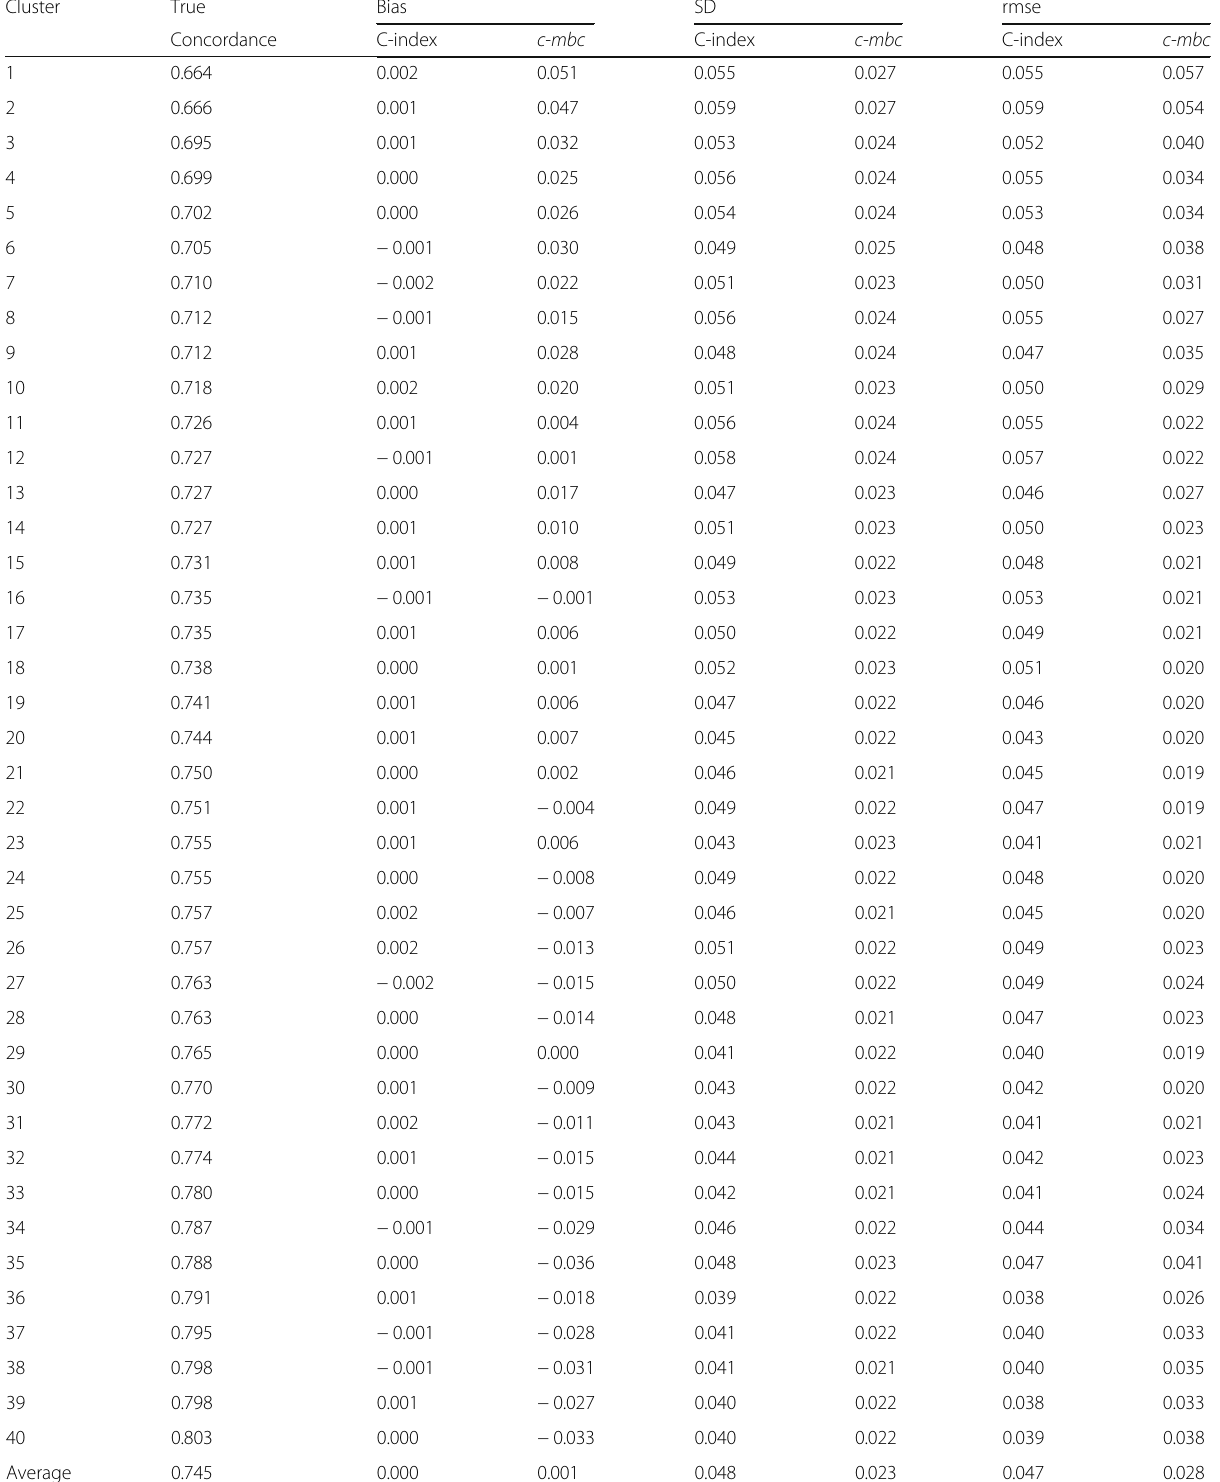
Table 1 Simulation characteristics (2000 replications) of c-index and c-mbc across 40 centers of 200 patients